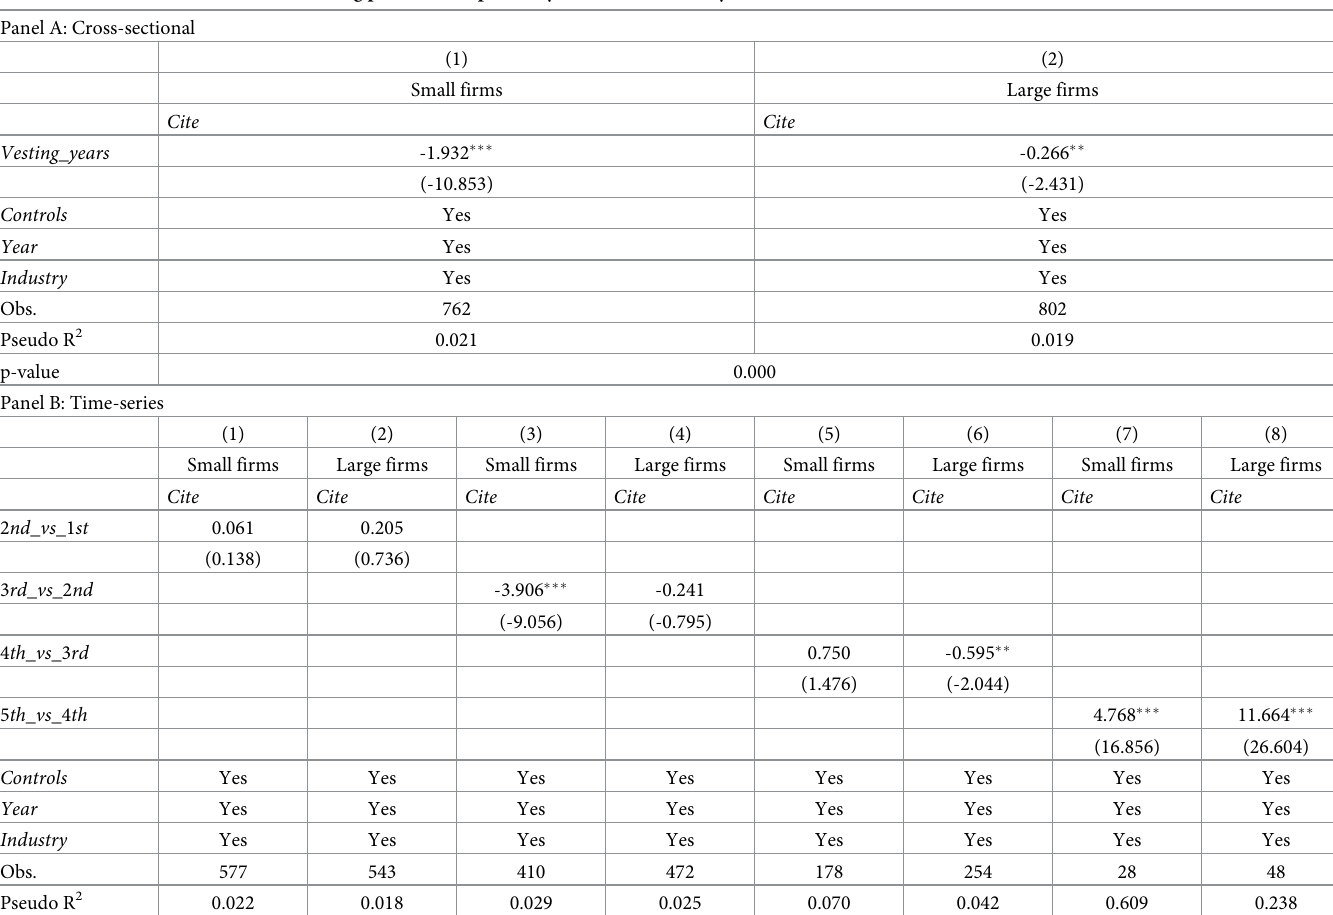
Table 6. Differences in the effects of vesting periods on exploratory innovation intensity: Firm size. Panel A: